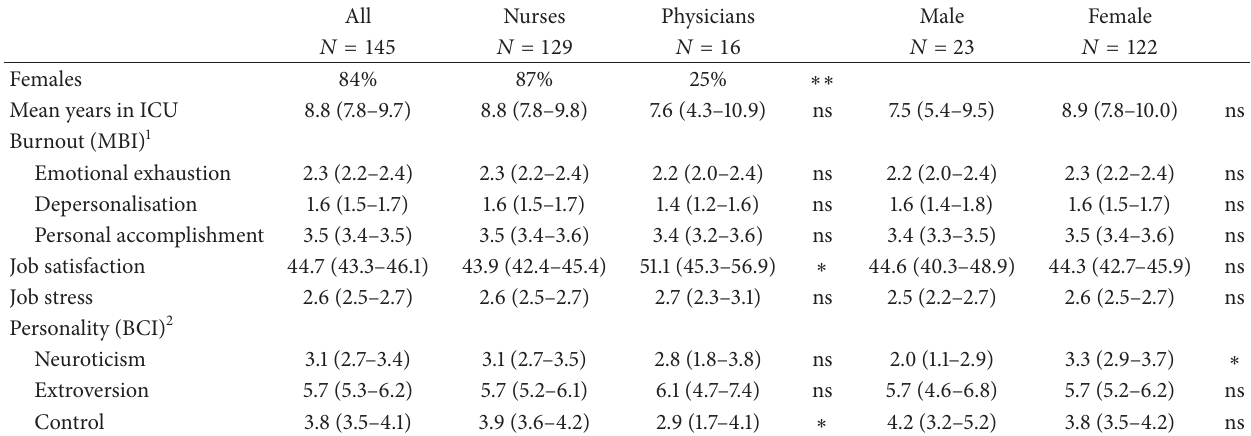
Table 2: Staff characteristics. Differences between professions and gender.